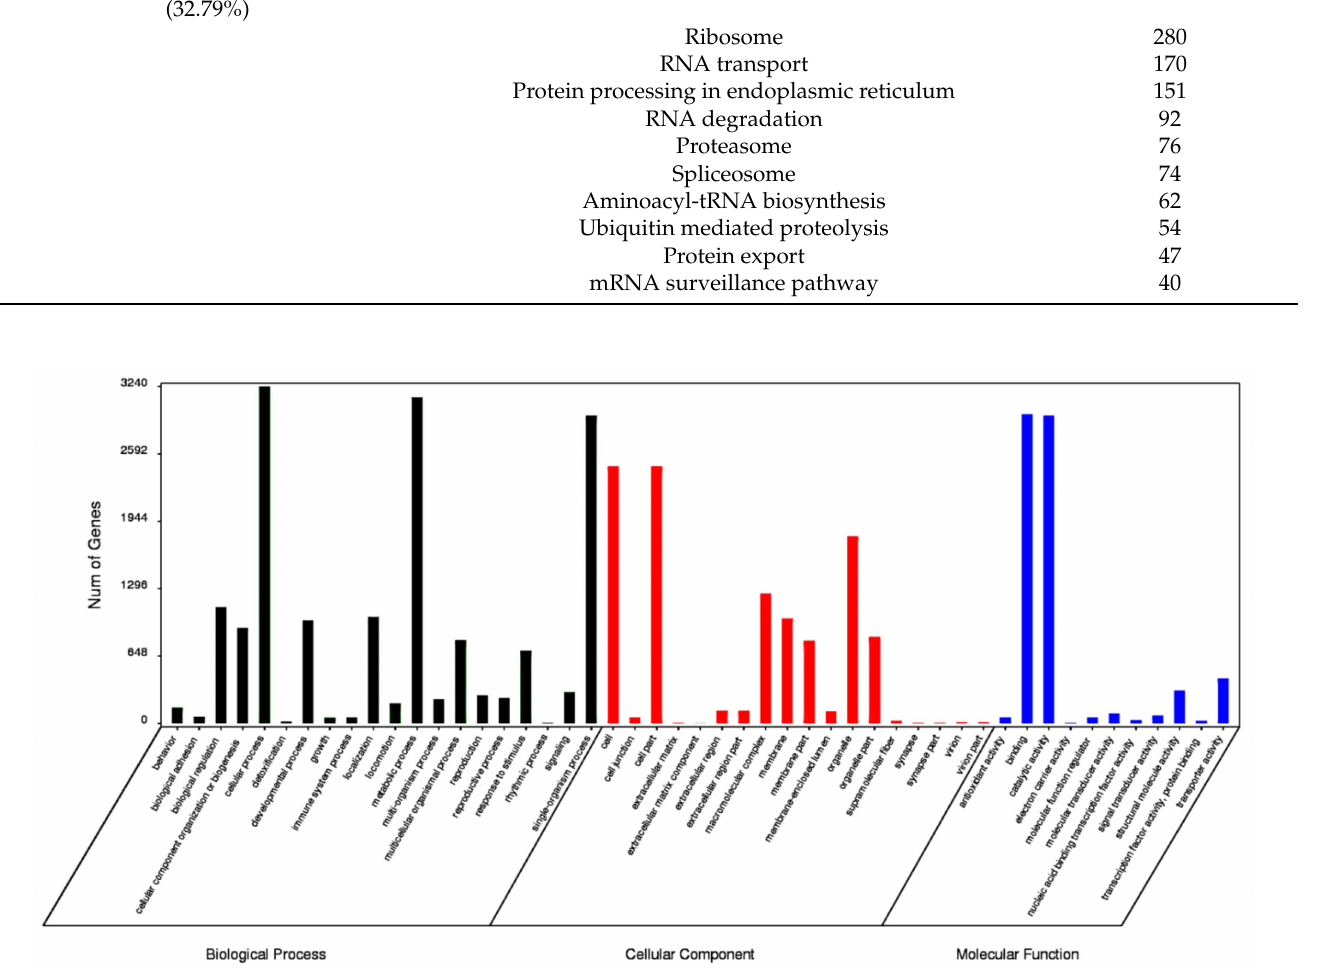
Figure 3. Gene Ontology (GO) distribution for B. dorsalis